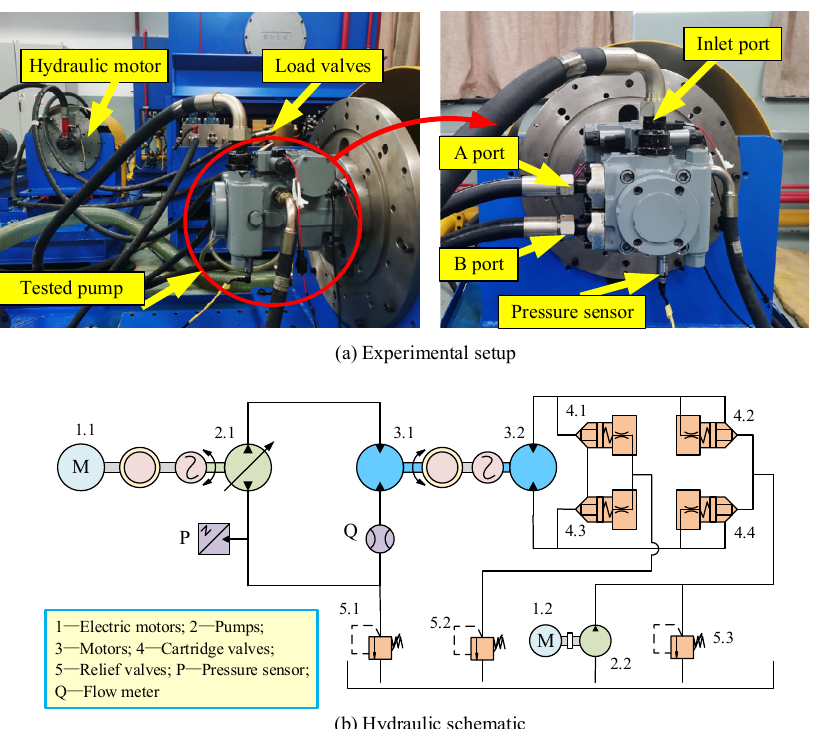
Figure 8. Experimental setup and its schematic.